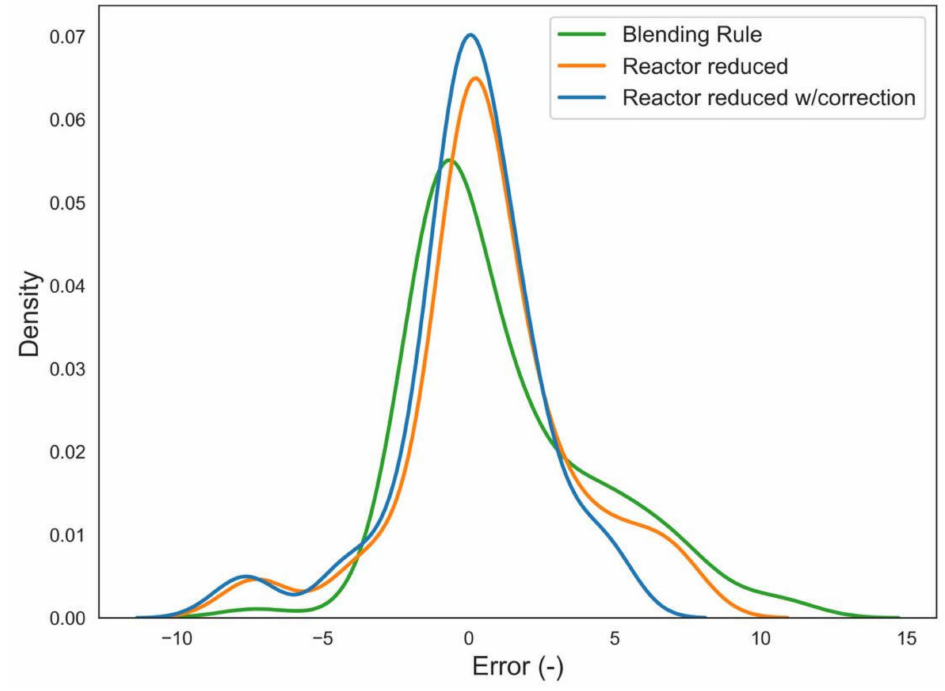
Figure 9. Effect of the tuned correction on the error (Calc–Exp of RON) distribution of reactor simulations in comparison with the reference blending